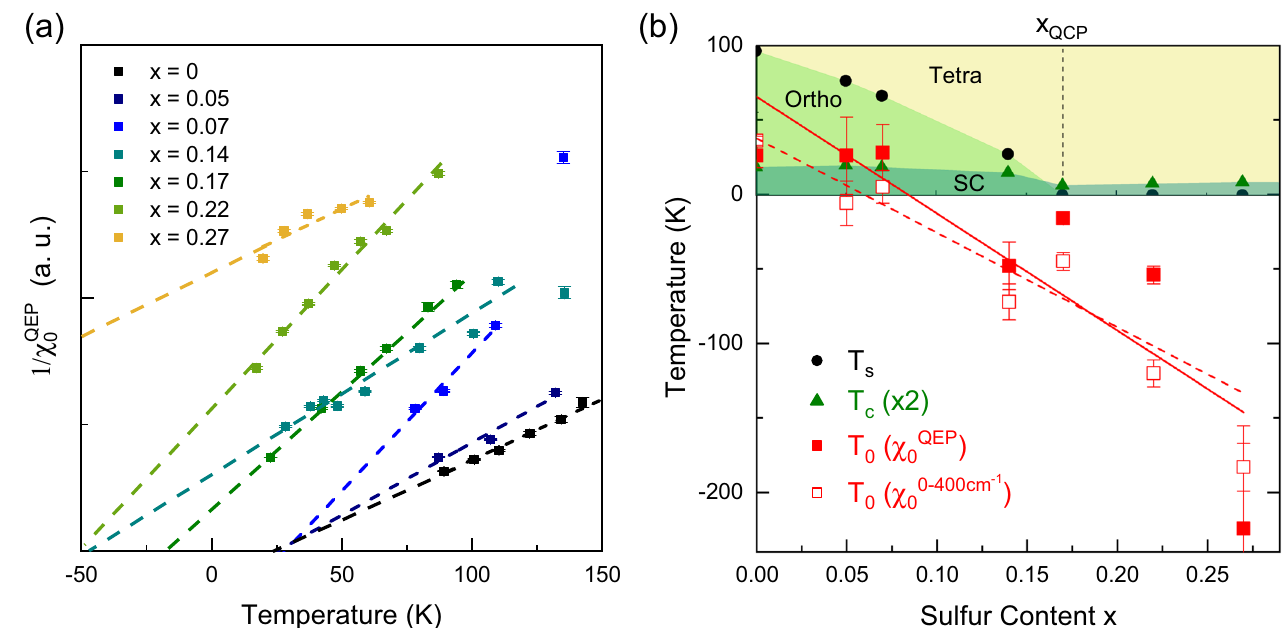
Fig. 4 Curie – Weiss analysis of the critical nematic susceptibility. a Curie – Weiss analysis of the critical inverse nematic susceptibility . Note that only data above T s are shown for low x compositions. b Phase diagram x − T of FeSe 1 − x S x showing the evolution of component χ QEP 0 the Curie – Weiss nematic transition temperature T 0 extracted from the analysis in ( a ) (full square). The error bars for T 0 correspond to standard errors of the Curie – Weiss fi ts. Also shown in open squares are the T 0 values extracted from a Curie – Weiss analysis of the χ 0 extracted without any fi tting by performing a Kramers – Kronig integration of the raw data restricted to energies below 400 cm − 1 (see Supplementary Fig. 6). The lines are linear fi ts of T 0 ( x )